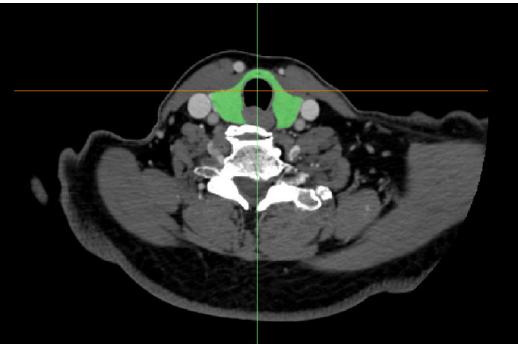
Figure 15. A highlight of an axial CT image, showing the delimitation of the segmentation mask (in green), applied over the structure to be segmented (i.e., in this case, the thyroid gland).